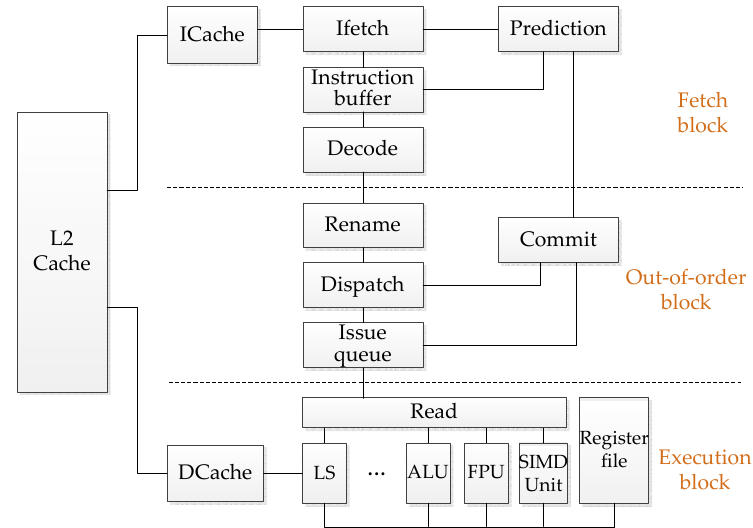
Figure 5. Logic view of FPGA implementation of PNX processor.